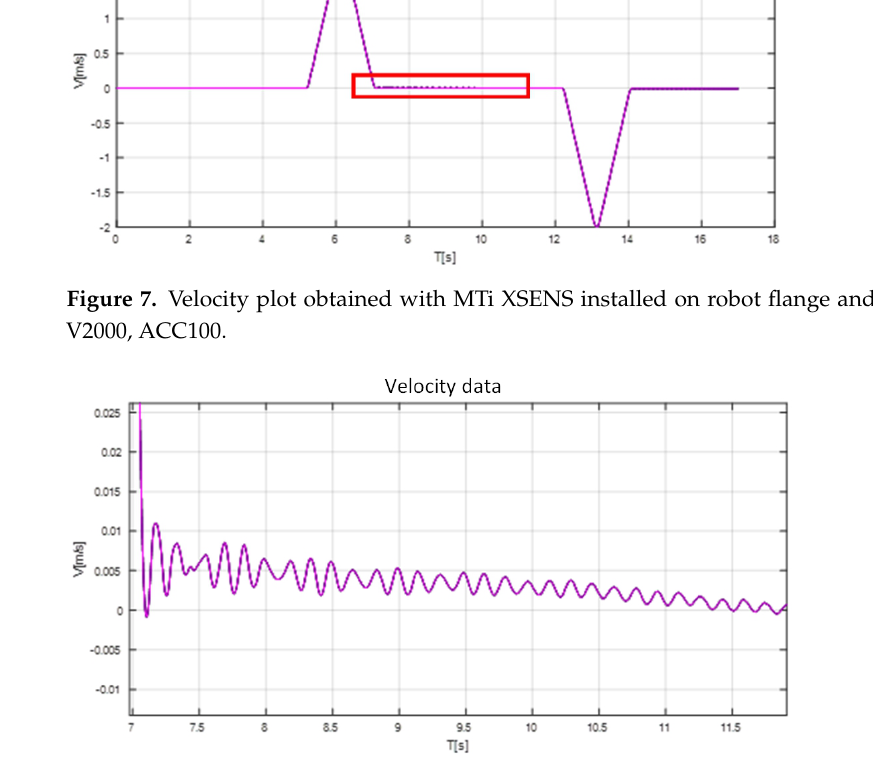
Figure 8. Highlighted area of the velocity plot as the robot stops for V2000, ACC 100.